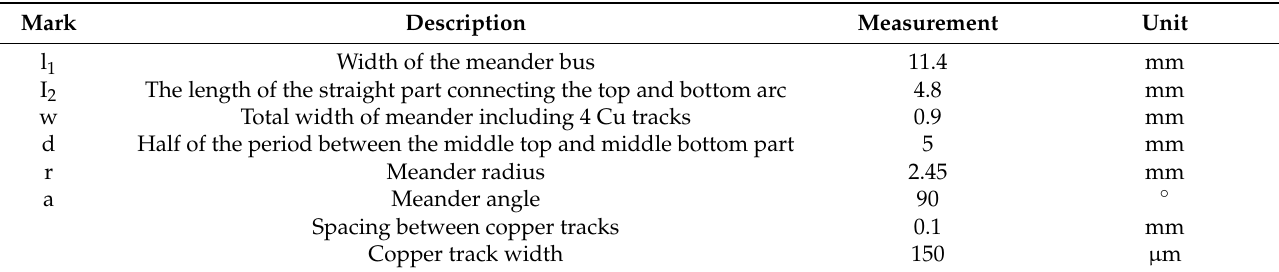
Table 2. Meander dimensions based on Figure 1d.